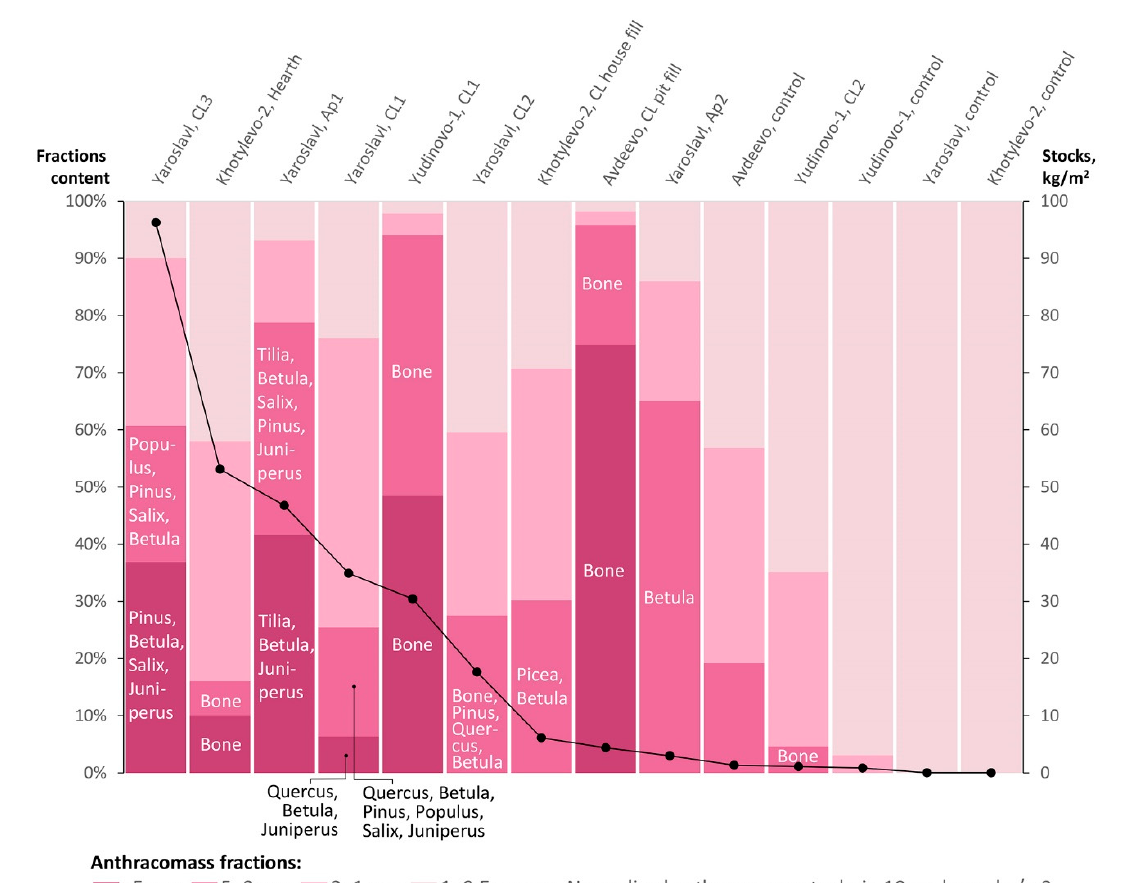
Figure 3. The particle-size distribution and identification of charcoal.